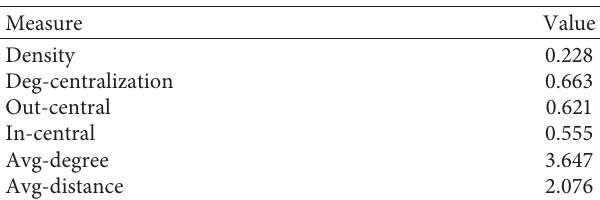
Figure 3: Subnets according to the nature of the actors. (a) Public actors. (b) Non-public actors: private organizations or Table 7: Cohesion measures.